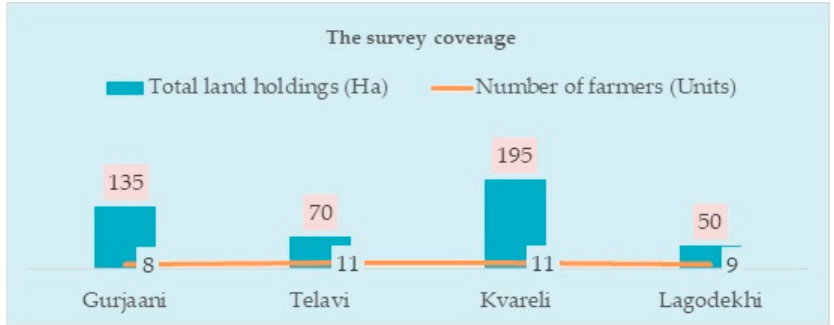
Figure 11. Number of surveyed farmers and total surveyed land holdings in targeted municipalities.